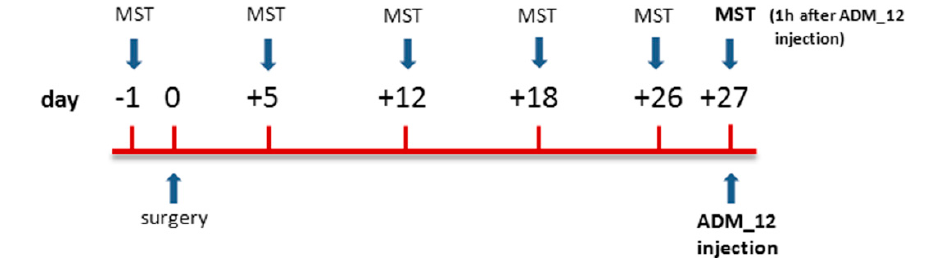
Figure 8. Schematic representation of the experimental design.